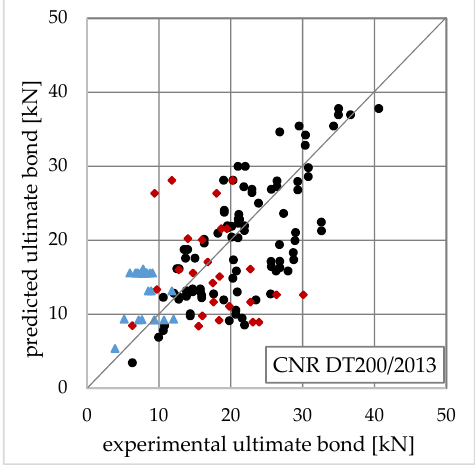
Figure 24. Test vs. predicted bond force using the CNR-DT200/2013 model [37].